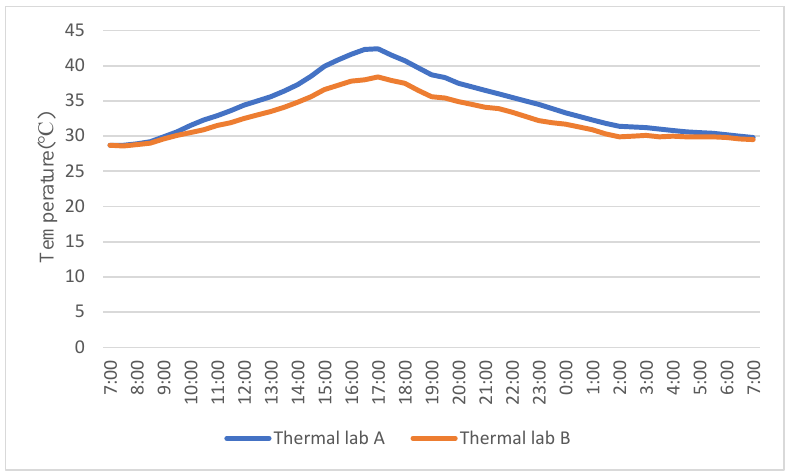
Figure 6. Experiment 1: Indoor temperature comparison.